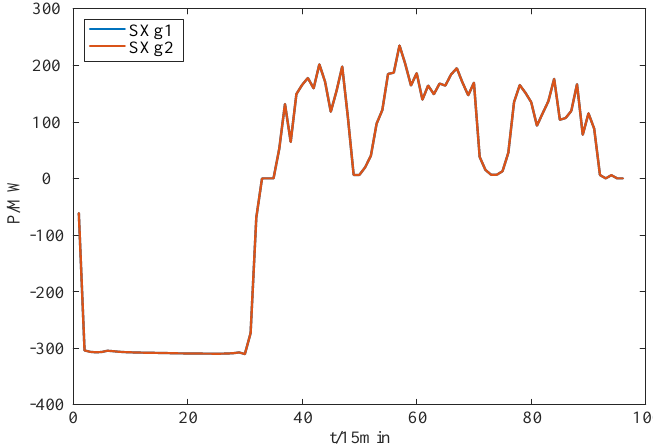
Figure 20. Active power output schedule of PSH units.